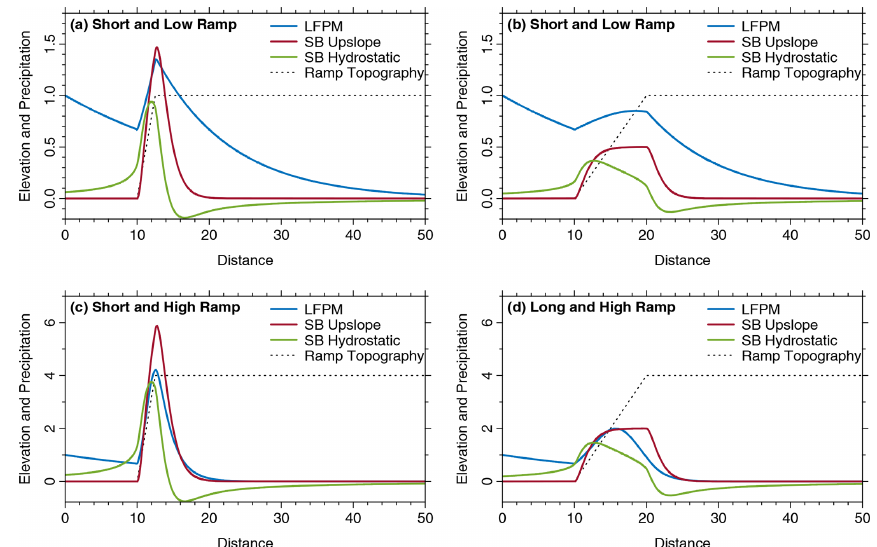
Figure 5. Comparison of the LFPM to the simple upslope version of the SB model and the version with advanced airflow dynamics in the hydrostatic